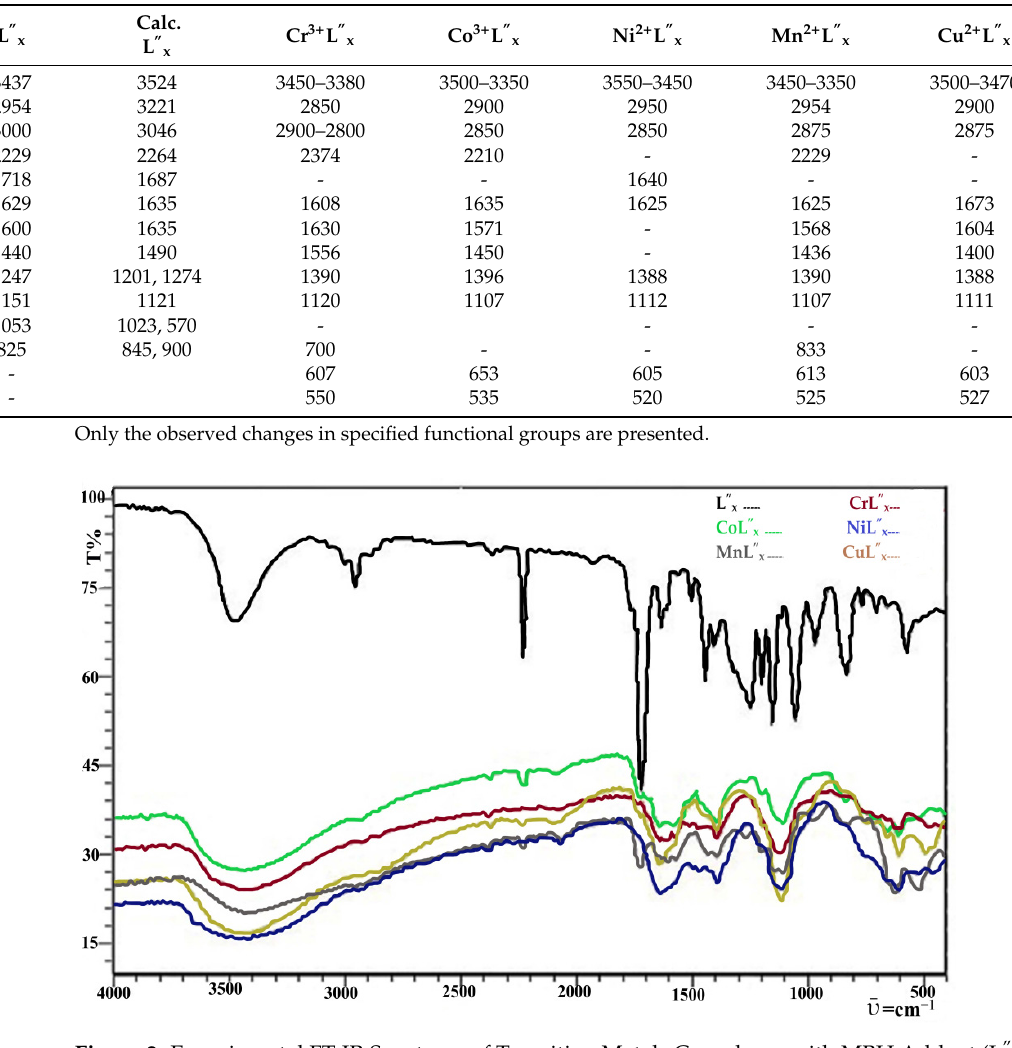
Figure 2. Experimental FT-IR Spectrum of Transition Metals Complexes with MBH Adduct (L ”x ). Table 3. Characteristic FTIR bands of the MBH Adduct (L ”x ) and its metal complexes (cm − 1 ) ῡ